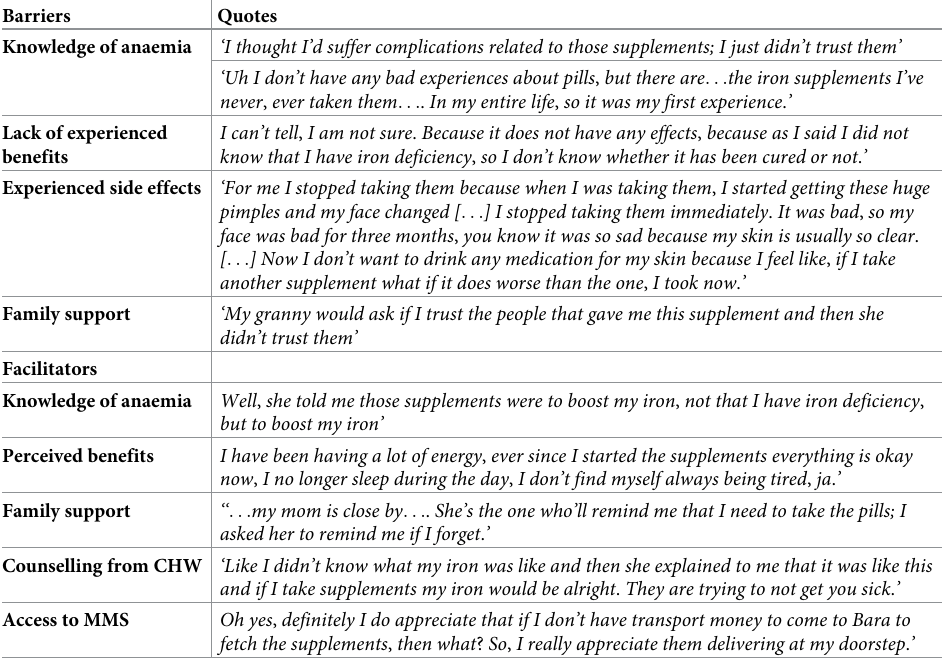
Table 1. Participant quotes regarding barriers and facilitators to supplementation adherence.